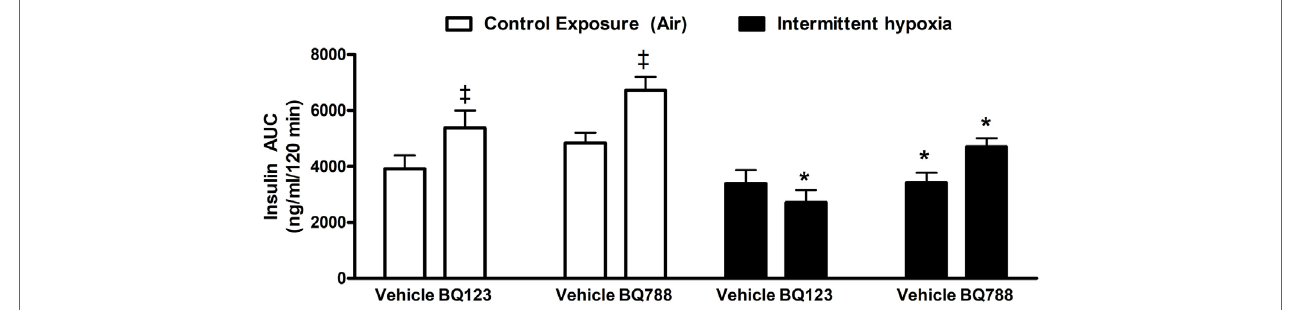
FigUre 4 | Area under glucose curve (AUC) during intraperitoneal insulin tolerance test. Interaction between hypoxic exposure and drug treatment was investigated using two-way ANOVA. * indicates p < 0.05 for differences between a control group (intermittent air) and a group exposed to intermittent hypoxia. ‡ indicates p < 0.05 for differences between a drug-treated versus vehicle-treated groups. N = 10 for each